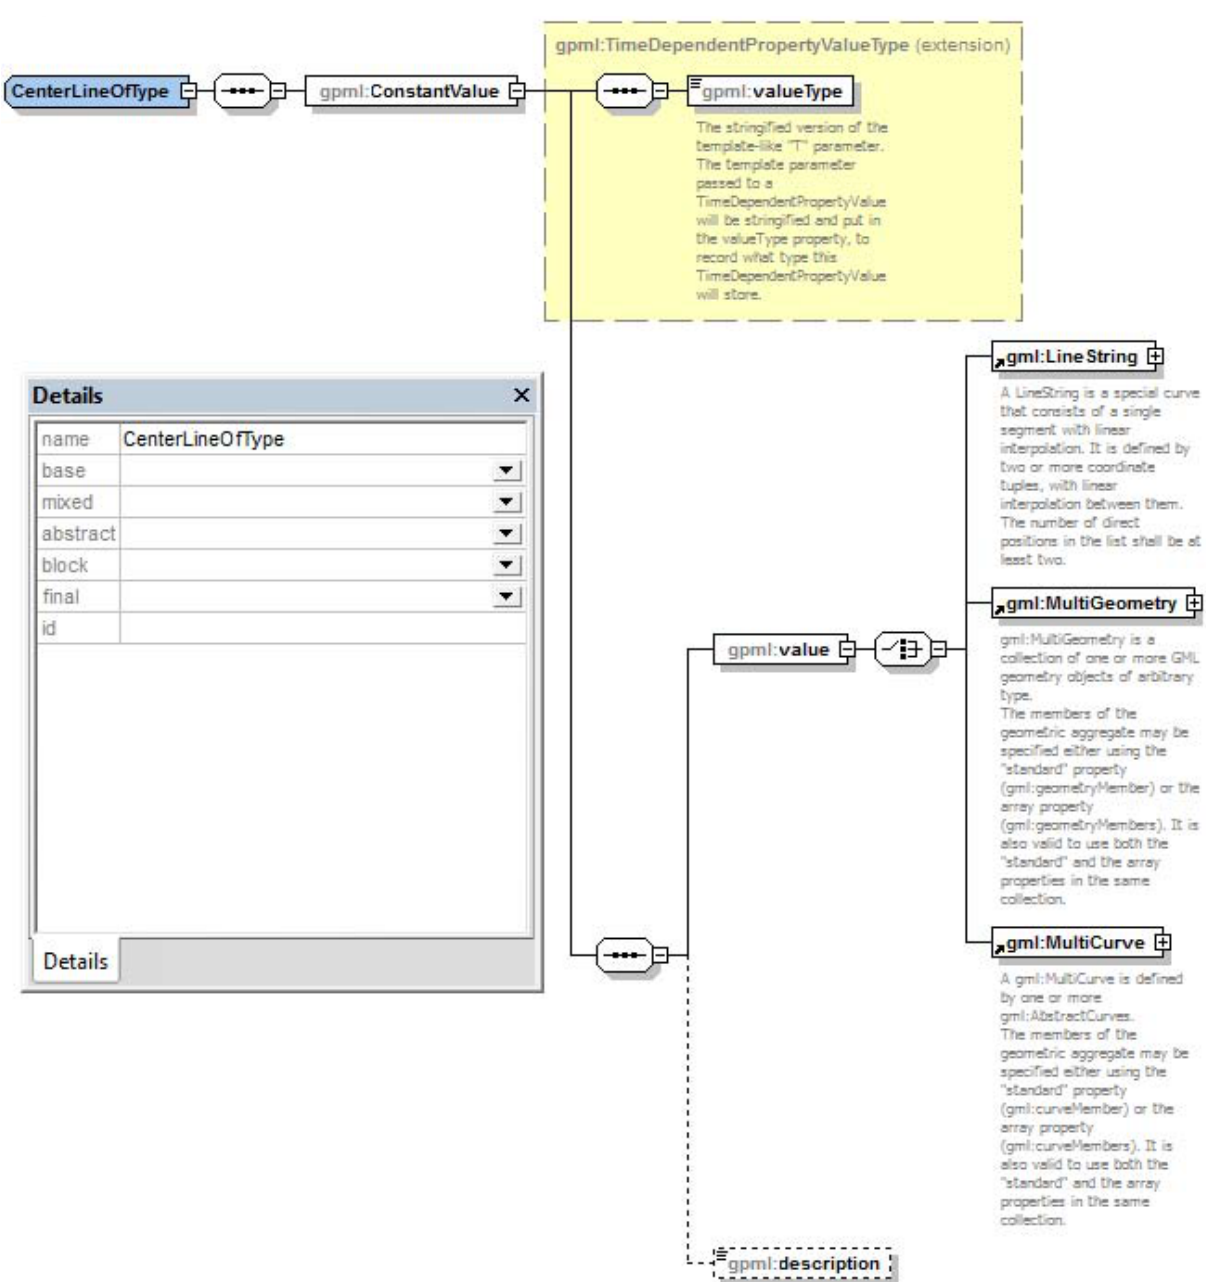
Fig. 16. The centerLine geometry schema diagram in